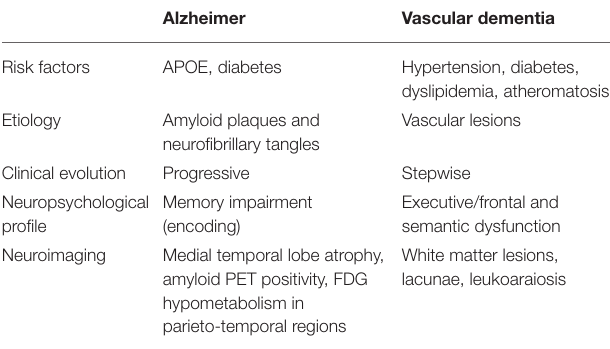
TABLE 1 | Summary of the main features of Alzheimer’s disease and vascular